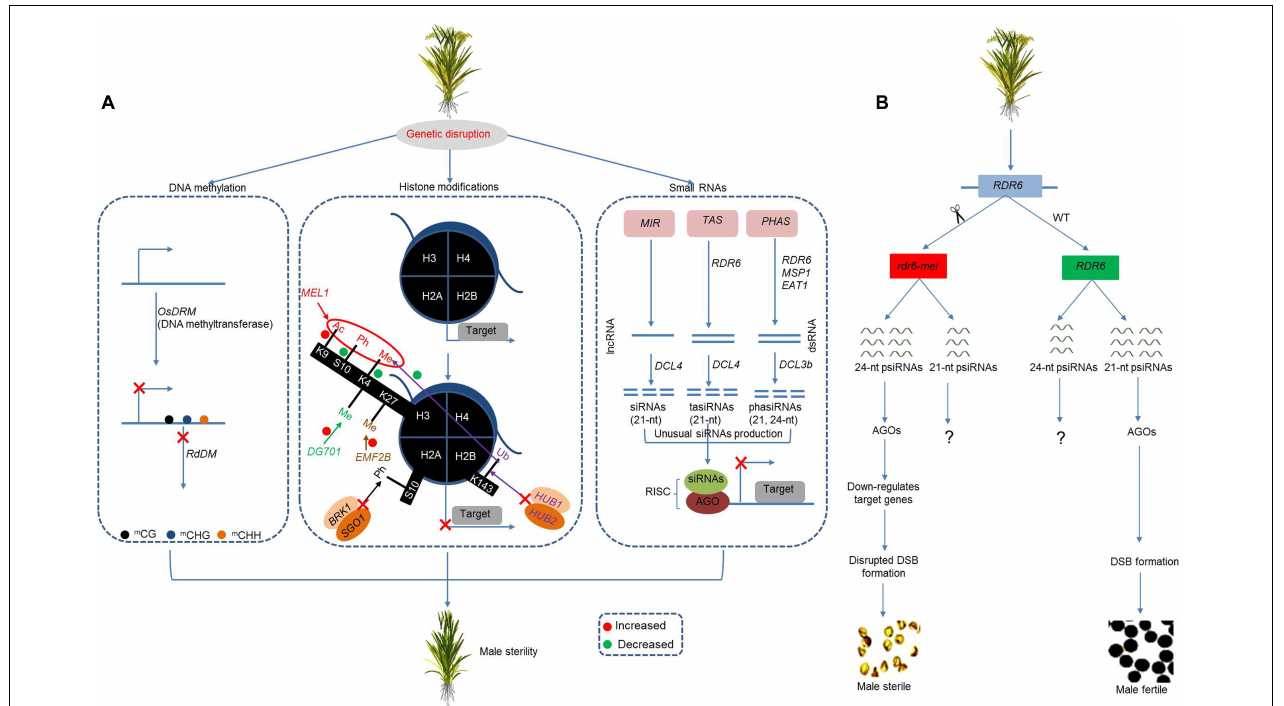
FIGURE 4 | Integrative model of the epigenetic regulation of male sterility in rice. (A) Genetic disruption in epigenetic-related genes diverges DNA methylation pattern and causes impaired histone modification and unusual production of small-interfering RNAs (siRNAs). The divergent epigenetic pathways cause gene silencing/inability to activate target genes and cause male sterility. (B) The mutation in OsRDR6 causes increased production of 24-nt psiRNAs, which, in coordination with AGO proteins, downregulates target genes, affects DSB formation, and causes male sterility. RdDM, RNA-directed DNA methylation; Ac, acetylation; Ph, phosphorylation; Me, methylation; Ub, ubiquitination; MIR, microRNA locus; AGO, Argonaute; lncRNA, long non-coding RNA; dsRNA, double-stranded RNA; RISC, RNA-induced silencing complex.